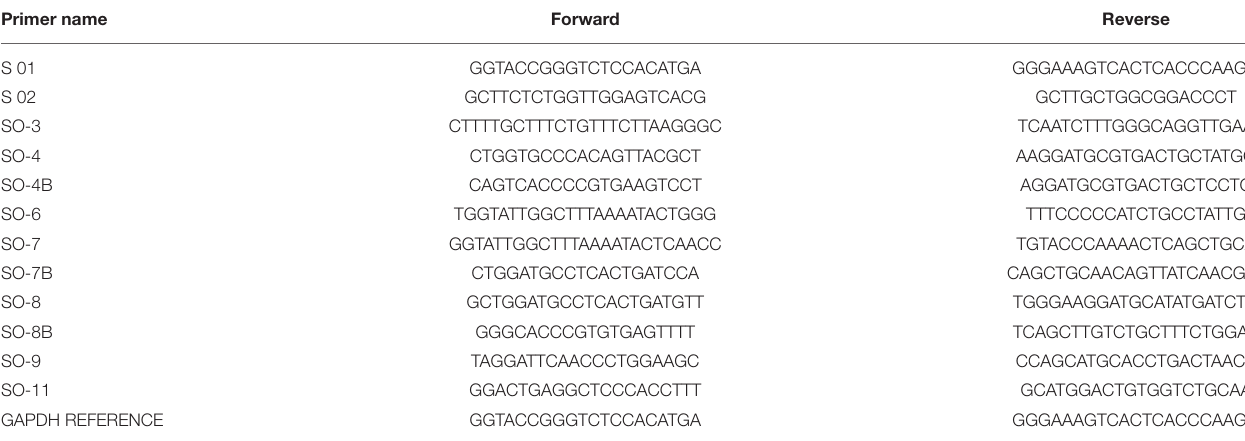
TABLE 2 | Sequences of primers for the insertion-deletion polymorphisms